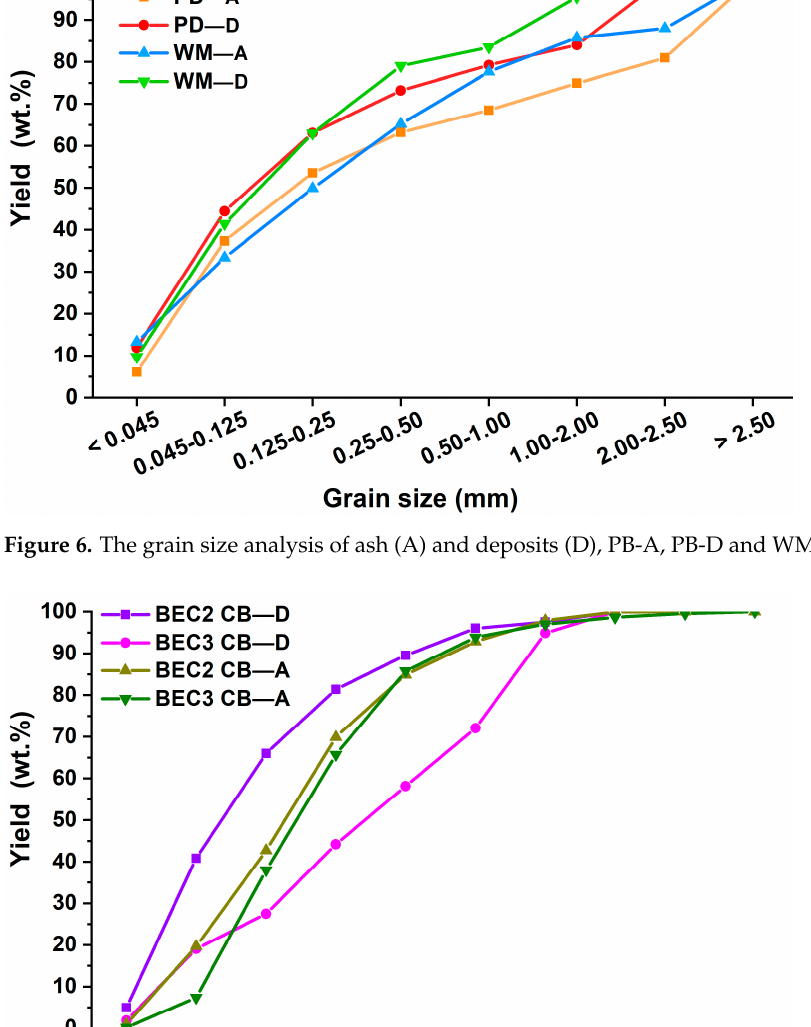
Figure 8. RE values for elements contained in ash and deposits from the combustion of CB ( a ) and PB ( b ); RE = Concen- tration of element in ash/ash percentage in the feed coal × Concentrations of elements in coal/100.